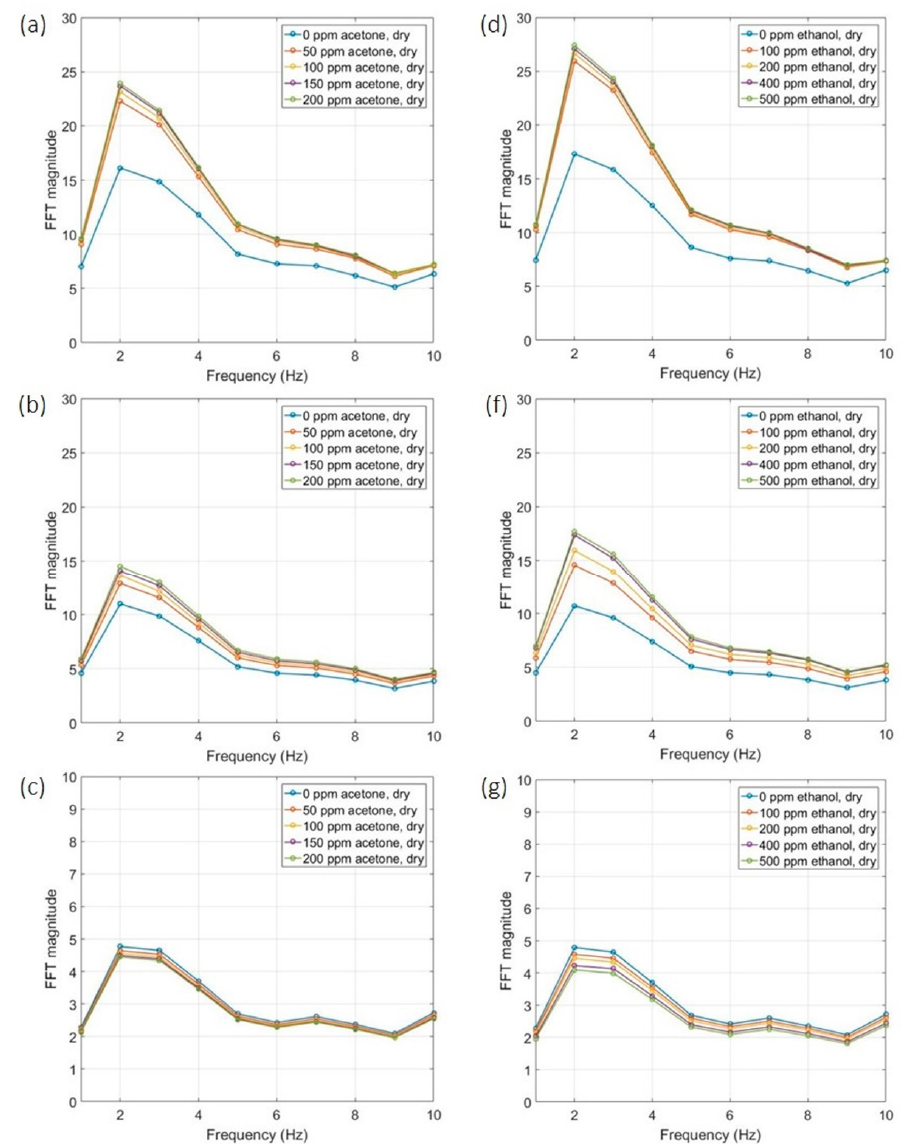
Figure 7. Real-time thermal modulation results of three metal oxide sensors towards acetone ( a – c ) and ethanol ( e – g ). Response of MOX1 SnO 2 sensor in ( a ) acetone and ( d ) ethanol; response of MOX2 WO 3 sensor in ( b ) acetone and ( f ) ethanol; response of MOX3 NiO sensor in ( c ) acetone and ( g ) ethanol.